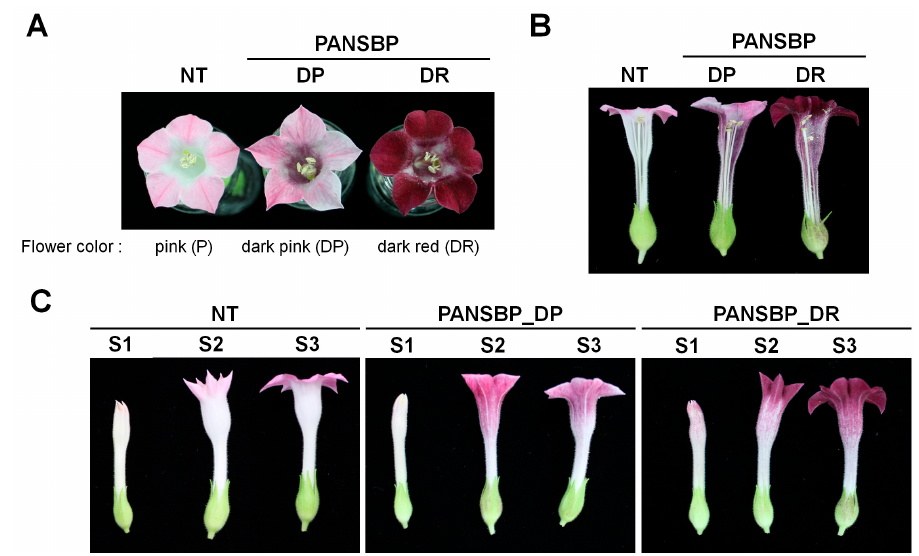
Figure 2. Flower color phenotype of PANSBP transgenic tobacco plants. ( A ) Color comparison of mature flowers from two PANSBP transgenic lines and NT tobacco plants. ( B ) Flowers were hand-sectioned longitudinally to display internal components. ( C ) Flower color variation among phenotypes throughout the three flower developmental stages, S1 to S3.